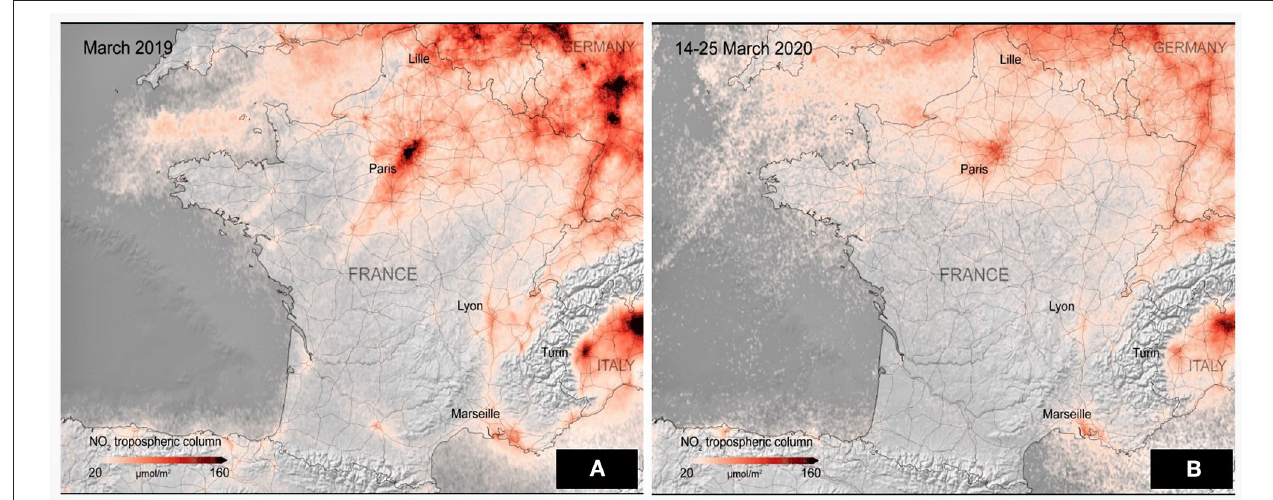
FIGURE 3 | Satellite images from ESA showing a dramatic reduction in the amount of harmful greenhouse gas emissions in the atmosphere. Pollution drops down in European countries amid coronavirus quarantine (A) As on March 2019, and (B) March 2020 (26).